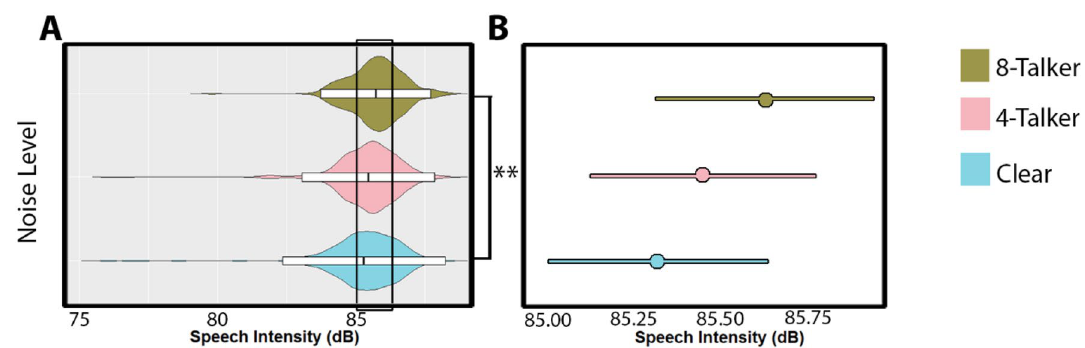
Figure 1. Overview of significantly affected speech acoustics across noise levels. Panel ( A ) depicts the raw distribution of Speech Intensity values, where the y-axis shows the three noise levels in ascending order, while the x-axis shows the raw acoustic values. Violins represent the kernel probability of the data at each point. Within each violin a boxplot shows the mean (middle bar) and two standard deviations from the mean (box hinges). Panel ( B ) depicts the model estimates for Speech Intensity. In other words, the predicted values of Speech Intensity based on noise level, while holding all other random terms constant. The central circle provides the mean, while the bars on either side provide the confidence intervals based on standard error. Significant contrast comparisons between noise levels are indicated by a bracket. ** p <